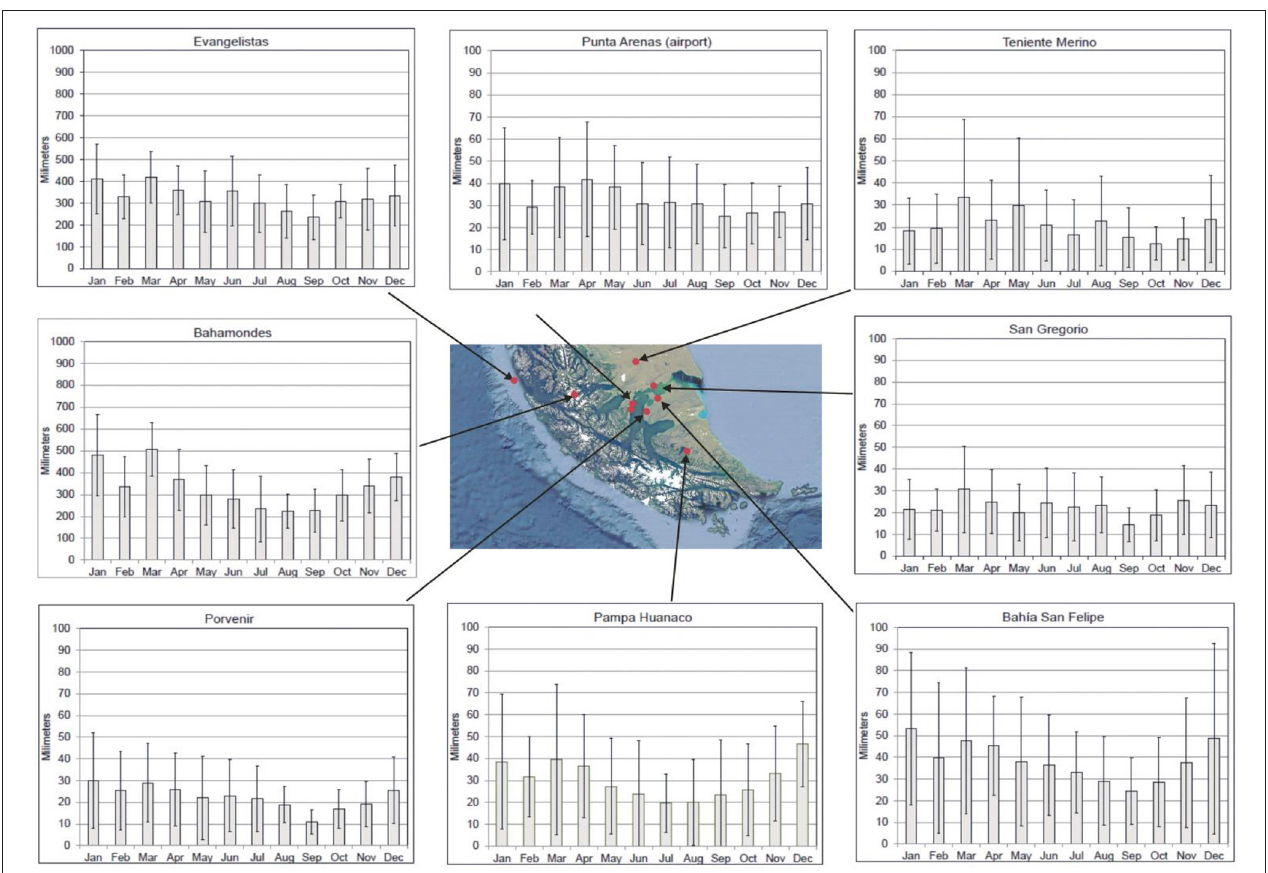
FIGURE 3 | Monthly precipitation averages over the period 2000–2016. Vertical lines are the 1st standard deviation. The red dot immediately south of Punta Arenas corresponds to Jorge Schythe station at Instituto de la Patagonia located in Punta Arenas city, shown in Figure 4 . Note that the vertical scale at Evangelistas and Bahamondes stations (the two western locations) have a range of 1,000mm, while the range for all the other stations is